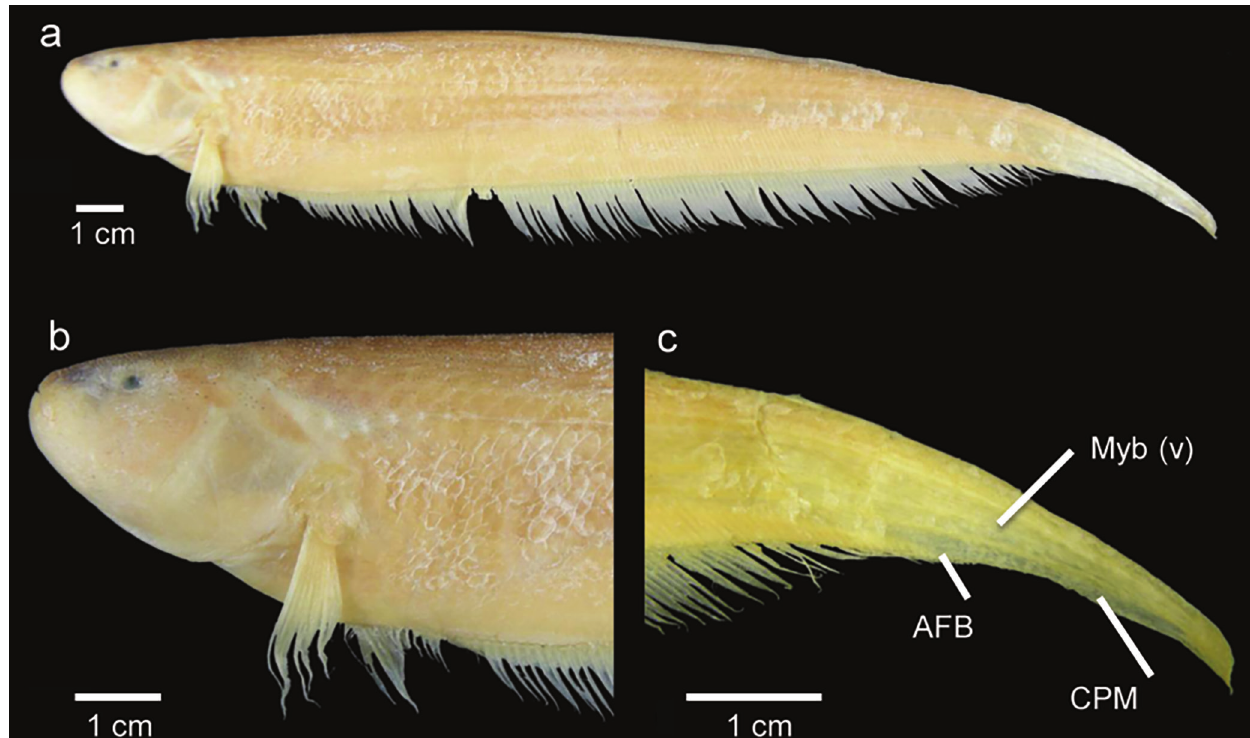
Fig. 7. Sternarchella patriciae holotype (MUSM 45239). a. Lateral view of the body, b. Head and anterior portion of body, c. Caudal region showing two rows of intermuscular bones (Myb), the anal-fin base (AFB) and the continuous caudal peduncle membrane